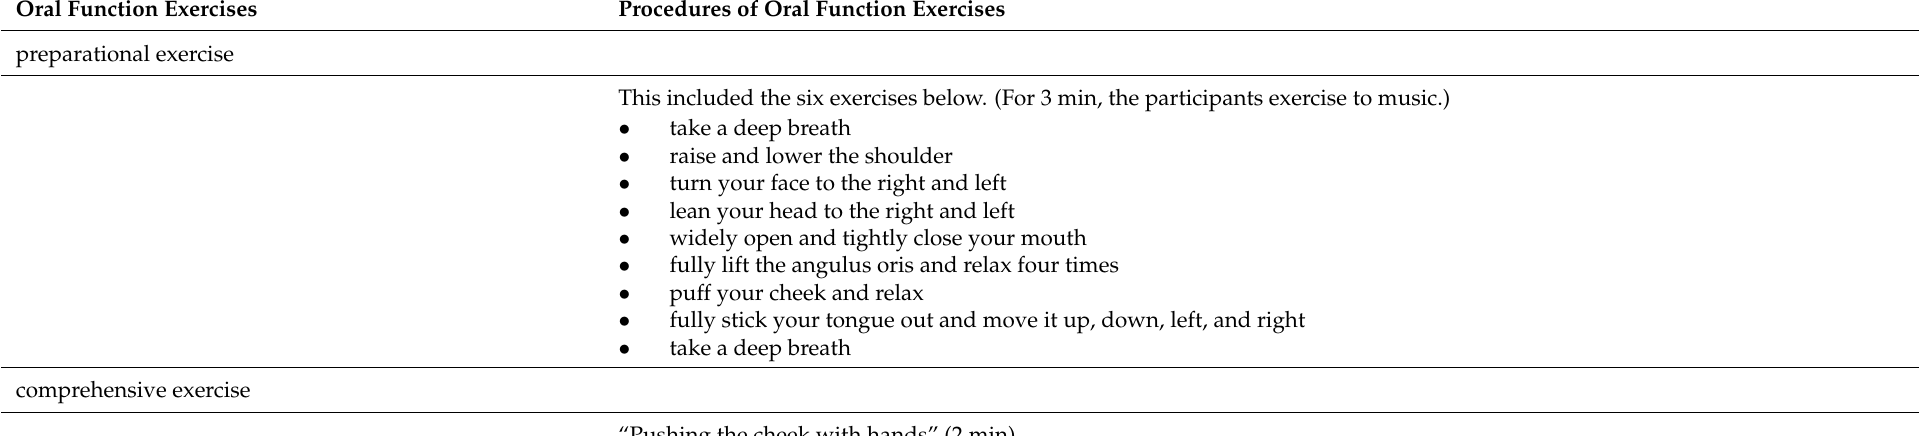
Table 1. Procedures and effects of oral function